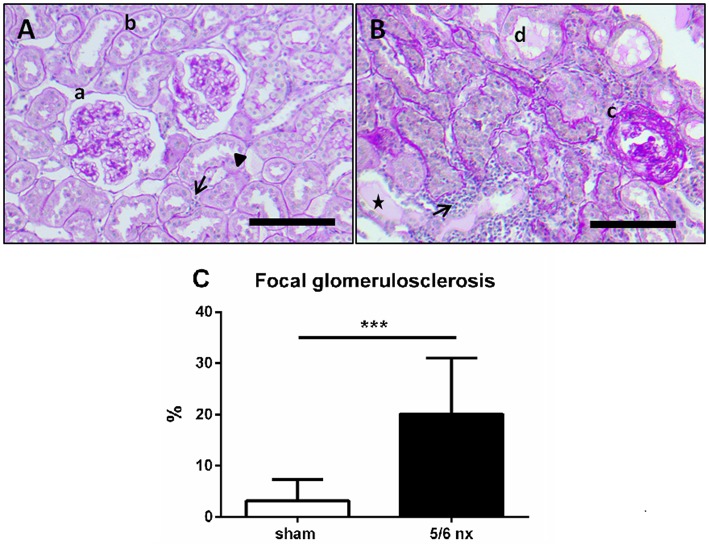
Representative pictures of renal histology in a sham-operated (A) and 5/6nx rat (B), and the incidence of focal glomerulosclerosis (C). In sham-operated rats (A), only a mild age-related alteration was found in renal parenchyma. While glomeruli were not sclerotic (a) and the endothelial cells of tubuli (b) were normal, tickening of the tubular basement membrane (triangle), and a slight infiltration of lymphocytes (arrow) was shown. Kidney damage in 5/6nx rats (B) was confirmed by glomerulosclerosis (c), tubular dilation and atrophy (d), perivascular infiltration of lymphocytes (arrow), and proteinuric tubular casts (asterisk). Scale bars represent 100 μm (magnification 100×). The incidence of glomerulosclerosis was significantly higher in 5/6nx rats in comparison to control rats. Data are presented as mean + SD. ***p < 0.001, n = 10/group; nx, nephrectomized.